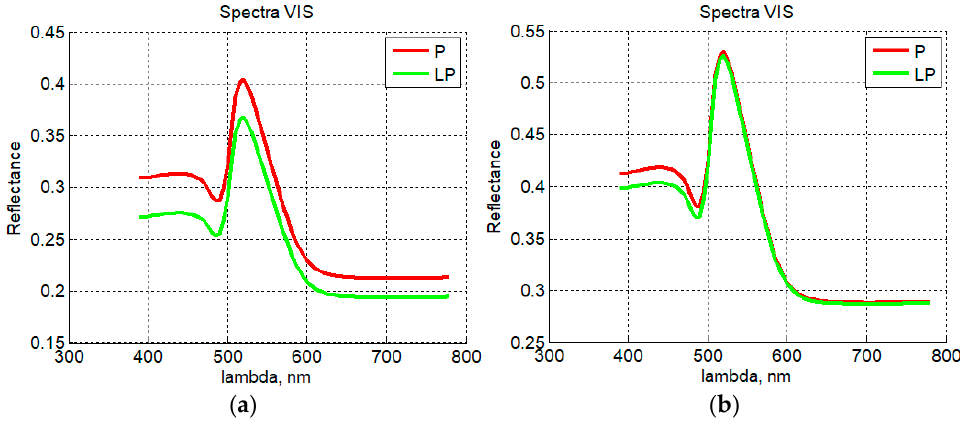
Figure 1. VIS spectral characteristics of mulberry leaves ( a ) adaxial part and ( b ) abaxial part. Figure 2 shows the averaged NIR spectral characteristics for the adaxial and abaxial part of a mulberry leaf. Both parts have strong overlapping spectral characteristics. The separation is observed in the 820–860 nm ranges as well as at 880–950 nm. In the second spectral range, the separation of the characteristics is more pronounced at the abaxial part of the leaves.